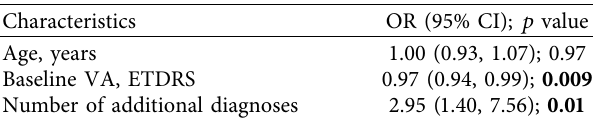
Bolded figures � statistically significant results at the 0.05 level. Abbrevia- tions: CI, confidence interval; ETDRS, Early Treatment Diabetic Reti- nopathy Study; OR, odds ratio; VA, visual